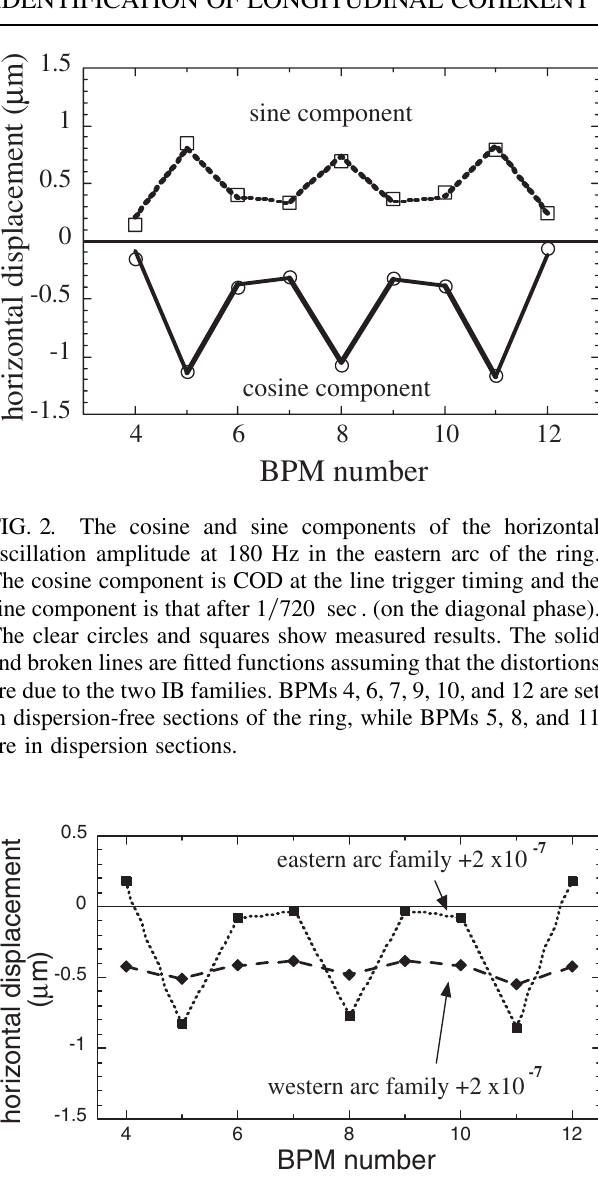
FIG. 3. Measurements of the horizontal COD under magnetic field variations due to the IB families (points). The dashed line and the dotted line show the calculated CODs produced by the IB families in the western and eastern arcs, respectively. The disagreement between the measurement and the calculation was less than 6% of the maximum.